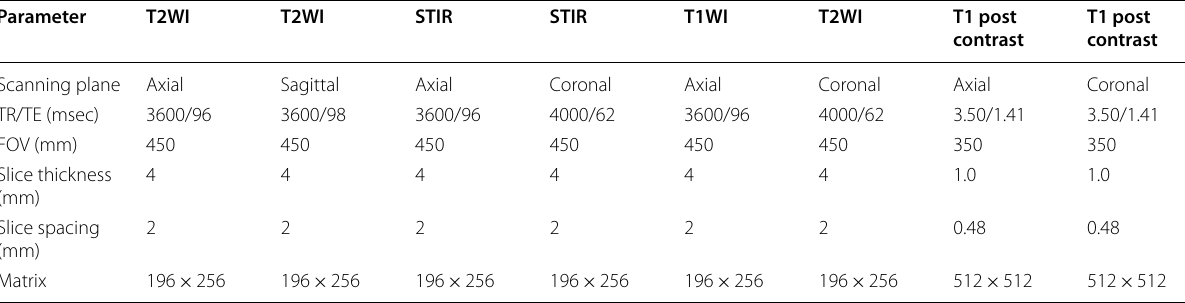
Table 1 Parameters of sequences used in MRI scans of anal fistulas Parameter T2WI T2WI STIR Scanning plane Axial